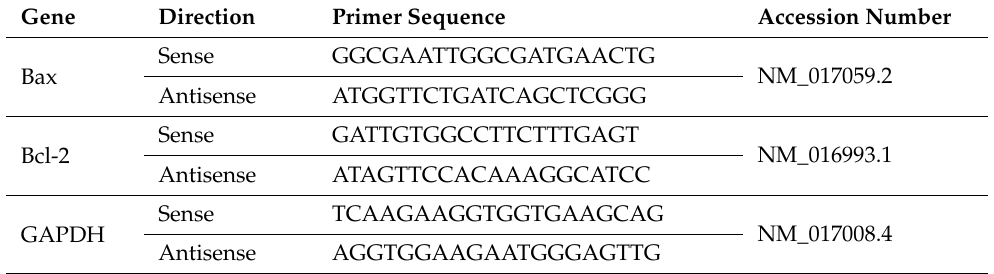
Table 1. Primers for gene expression by